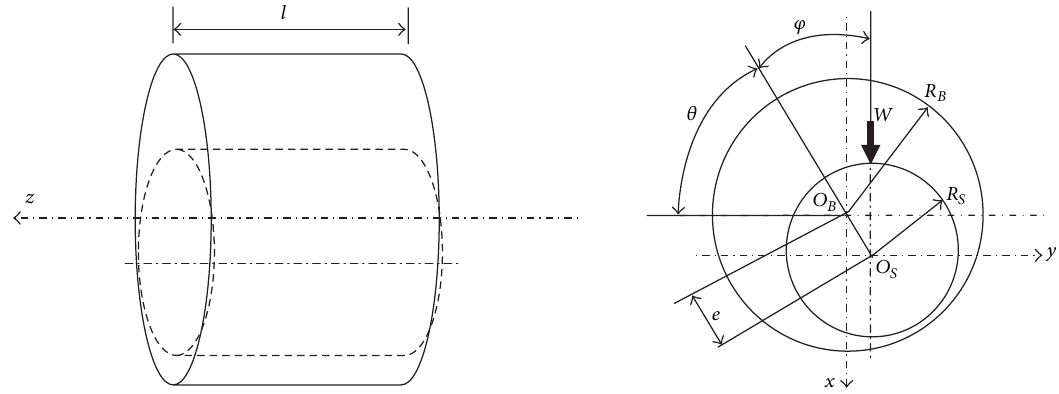
Figure 1: Schematic representation of a journal